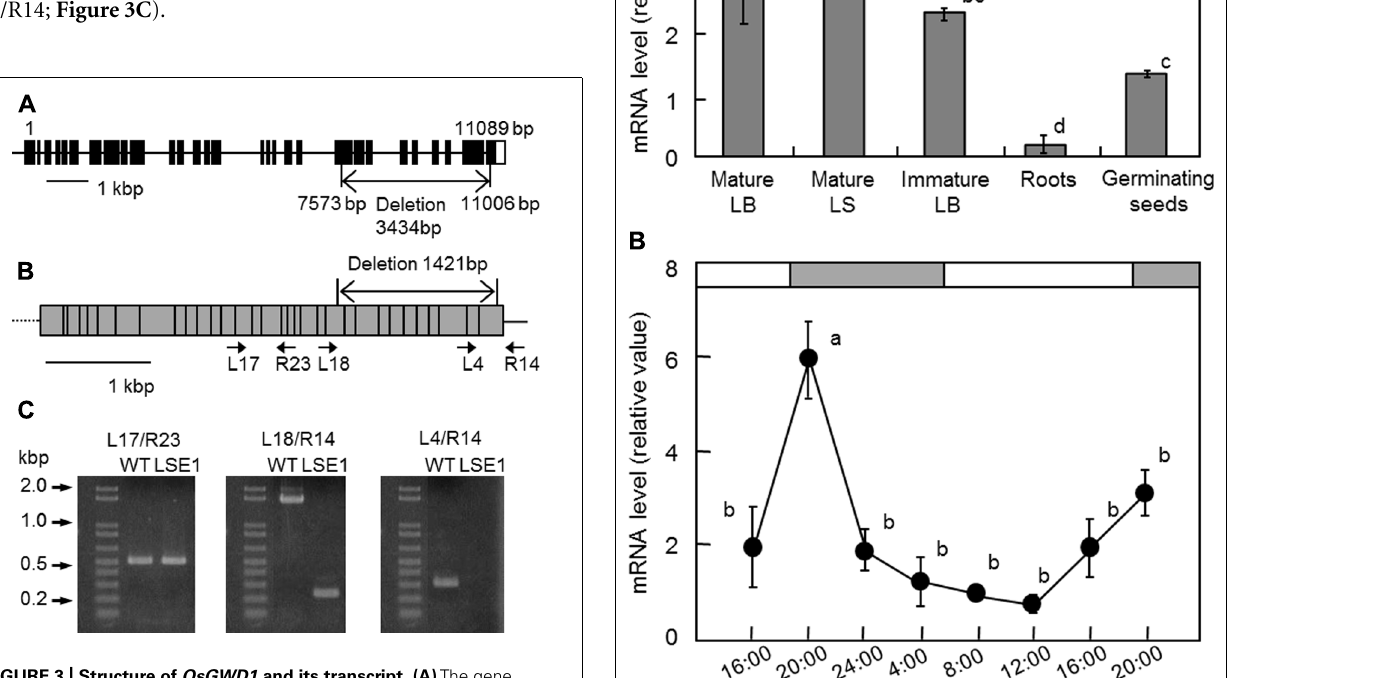
FIGURE 3 | Structure of OsGWD1 and its transcript. (A) The gene structure of OsGWD1 is illustrated; black boxes indicate exons and the position of the gene deletion in LSE1 mutant is shown by an arrow. (B) The coding region of the OsGWD1 transcript is indicated by a gray rectangle, in which the junctions of the exons are shown by vertical bars.The positions of the PCR primers used for the analysis of the transcript structure are indicated by the arrow heads (see below). Note that the primers L17, L18, L4, and R23 span the exon/intron junction on the cDNA. (C) Agarose gel electrophoresis images of the PCR products are presented to demonstrate that an aberrant transcript is accumulated in the leaves of LSE1 plants.The results of PCR with the different primer pairs are shown.